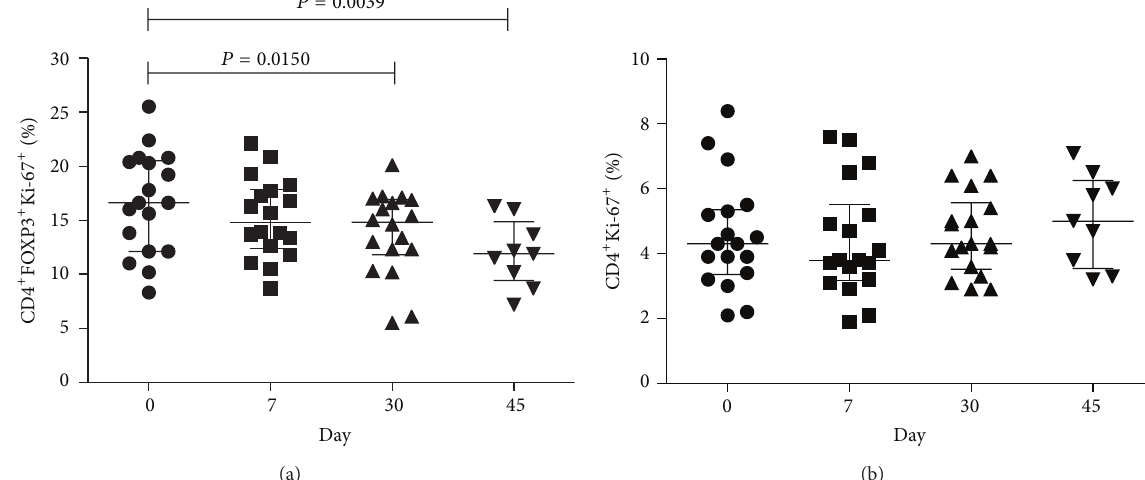
Figure 3: Treg from statins-treated individuals have lower Ki67 expression. Cell cycling was evaluated by the expression of Ki-67 by CD4 + FOXP3 + Treg cells (a) and total CD4 + T cells from peripheral blood of healthy donors treated with statins (b). Median, interquartile range (IQR), and 𝑃 values are shown in the graph; difference between days was tested by Wilcoxon signed-rank test.